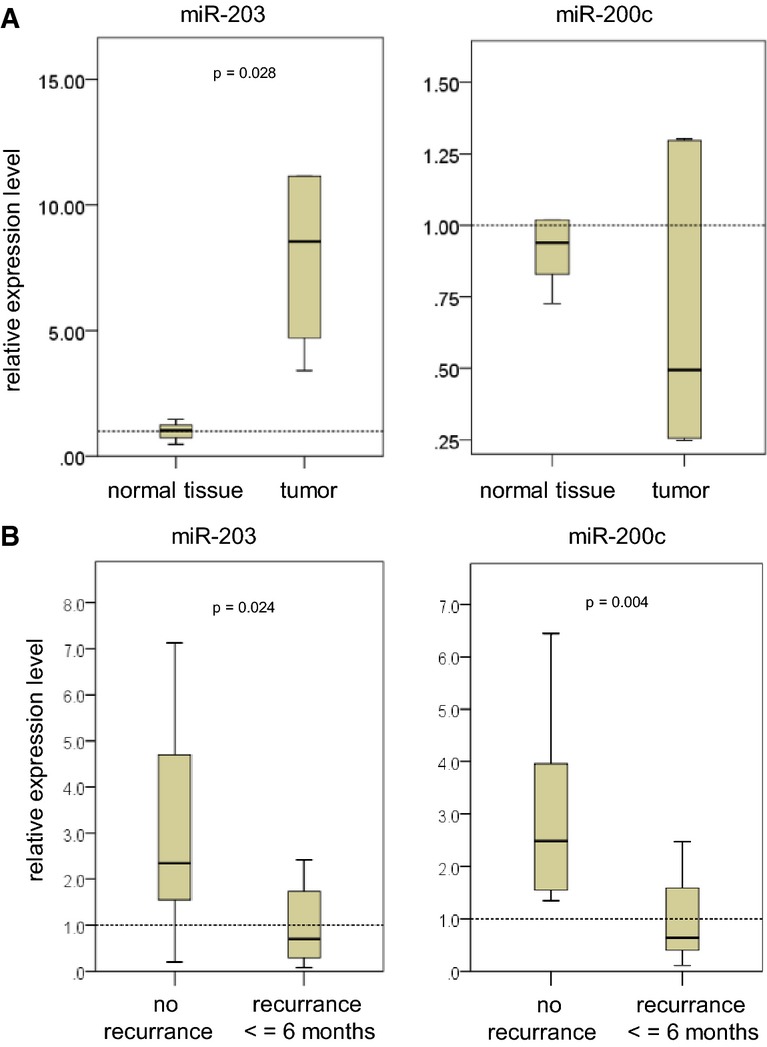
Clinical relevance of miR-203 expression

A, B Relative expression levels of miR-203 and miR-200c in pancreatic adenocarcinomas. (A) In normal versus tumor tissue of the same case (n = 6 cases), (B) in the non-recurrence (n = 10 cases) versus the recurrence group (n = 11 cases). The mean value of the lower group in each figure was set to 1. Nonparametric Mann–Whitney U-test.